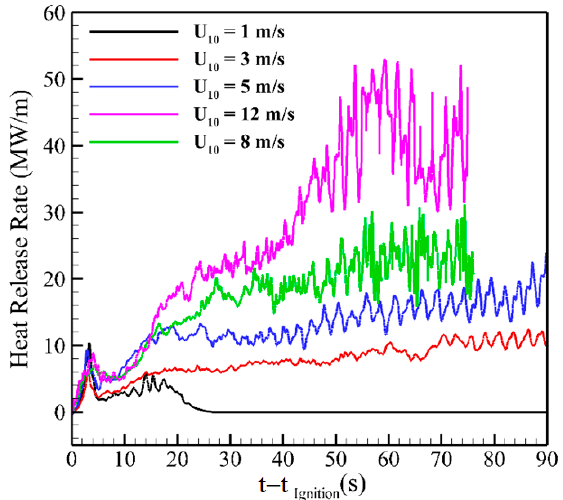
Figure 13. Time evolution the total heat release rate per unit length of fire line obtained for different wind speeds from Equation (2).